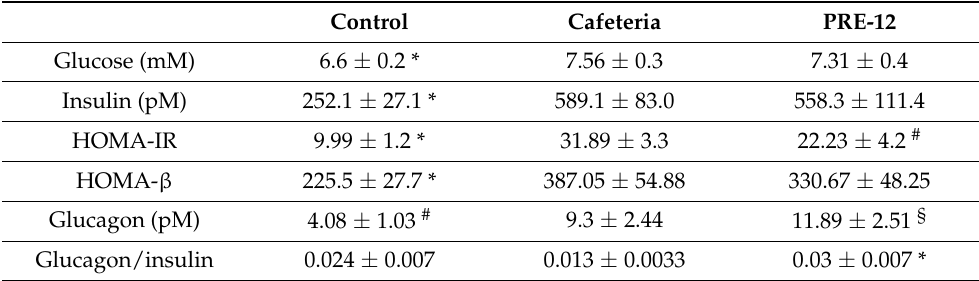
Table 1. Fasting plasma parameters at the sacrifice of rats treated for 12 weeks with a cafeteria diet with/without a 10-day pre-treatment with grapeseed proanthocyanidin extract